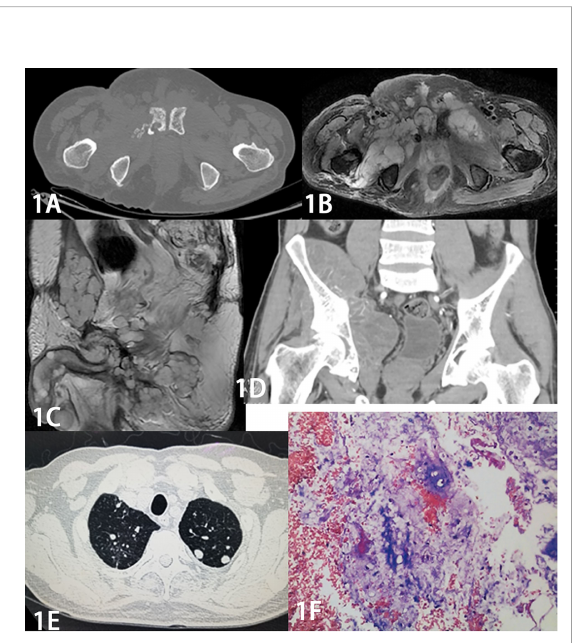
FIGURE 1 Male, 64 years old, with a former sacrococcygeal chordoma that recurred 8 times over 9 years. The recurrent tumor increased signi fi cantly in extent with the number of recurrences. Figure 1A Axial CT shows osteolytic destruction of the right side of the pubic symphysis with a soft tissue mass. Figure 1B MR axial and Figure 1C sagittal T 2 WI pelvic area and bilateral medial thigh masses showed “ pebble-like ” clusters of apparently high-signal mass nodules with low-signal intervals. Figure 1D Coronal CT enhancement scan shows signi fi cant inhomogeneous enhancement. Figure 1E CT shows multiple small metastatic nodules in both lungs. The pathology of Figure 1F shows a few small round cells scattered in a background of mucus-like stroma, and combined with the immunohistochemical results (S- 100 protein positive, GFAP positive, D2-40 positive, EMA negative), the diagnosis of chordoma was